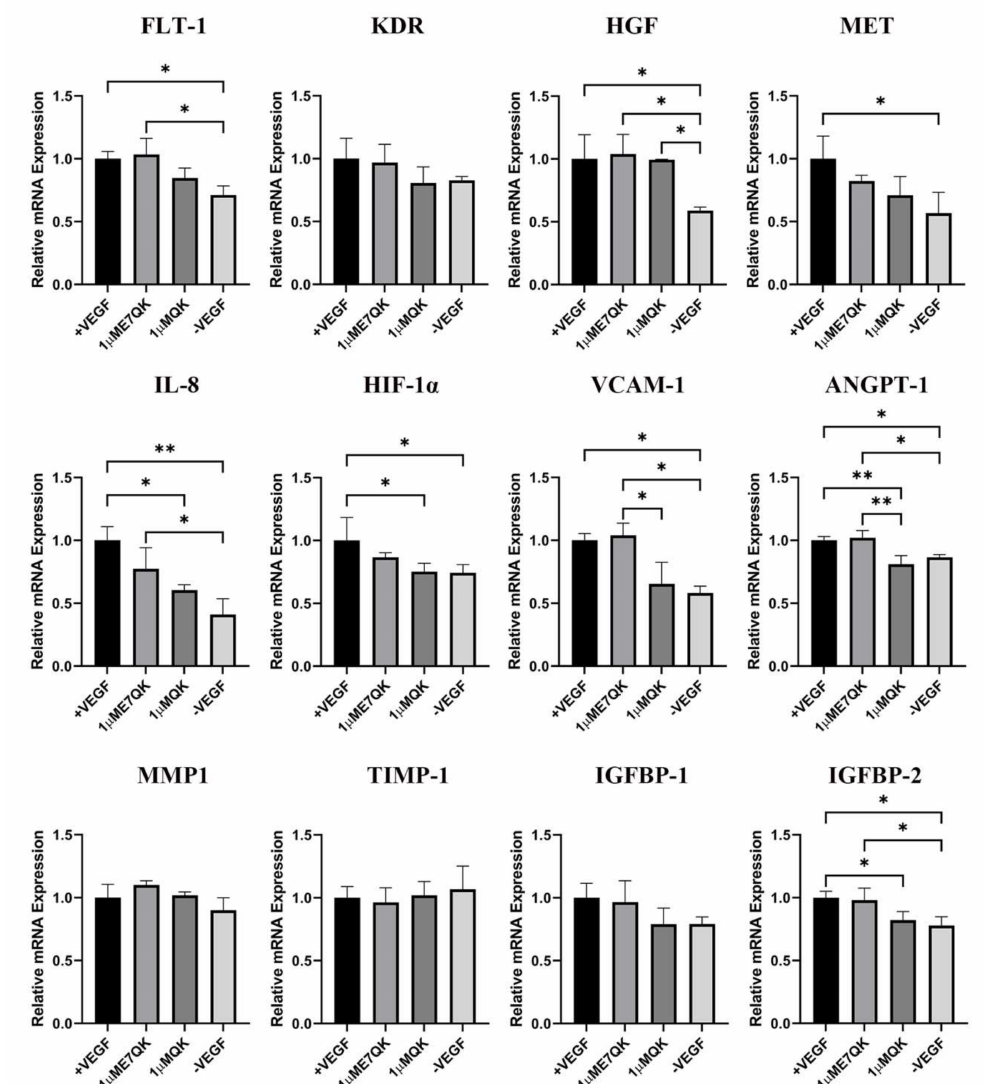
Figure 4. Expression of angiogenesis-related genes by HUVECs stimulated with QK and E7-QK peptide. Gene expression levels were quantified using a Light Cycler instrument, and ratios of mRNA copy numbers of the housekeeping gene (GAPDH) were calculated. Gene expression mean values ± SD in HUVECs from the 1 µ M E7-QK peptide, QK peptide, VEGF (0.5 ng/mL, positive control group), or without VEGF (negative control group) groups were displayed as x-fold induction values relative to the VEGF positive group. Data were collected from three independent experiments (* p < 0.05; ** p <